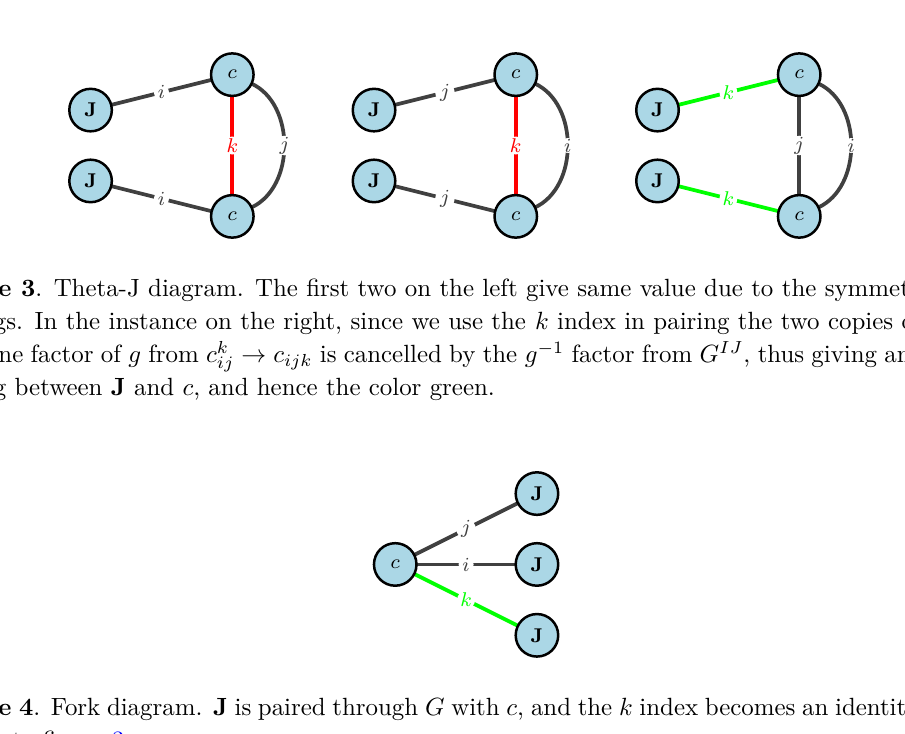
Figure 2 . Bar diagram. Notice the pairing is done via g − 1 and not g , as unlike the theta diagram where there is a factor of g from the k index of c ijk , there is no such factor from J k , 3 . We have the same pairings for indices i and j , and note that their values are the same as the one above.